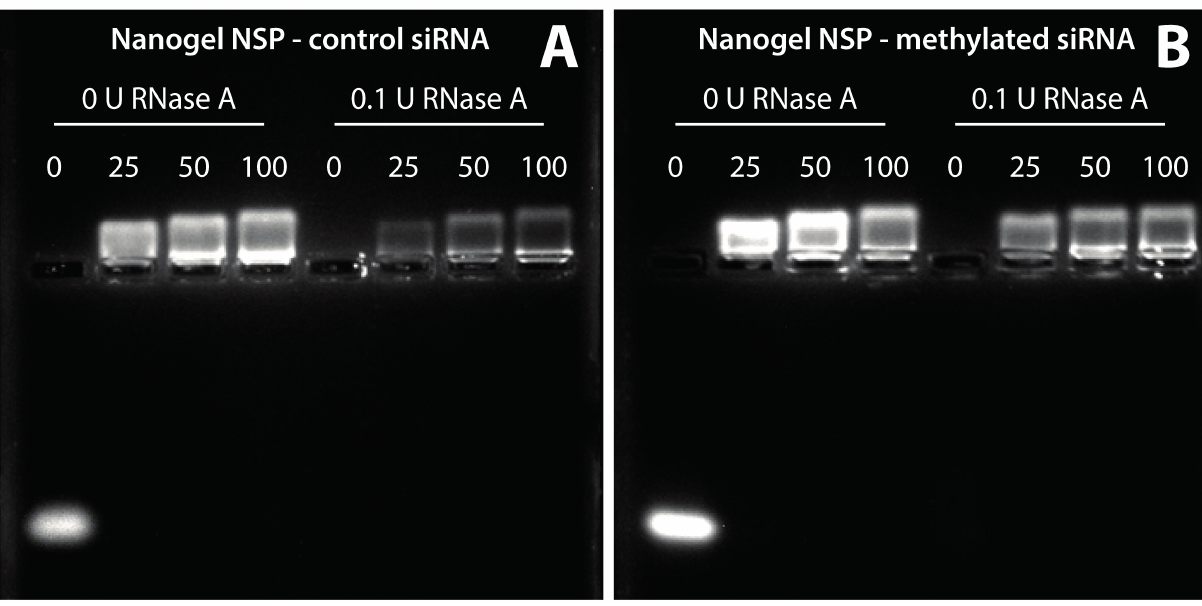
Figure 1. Evaluation of siRNA protection in the presence of a potent endonuclease, RNase